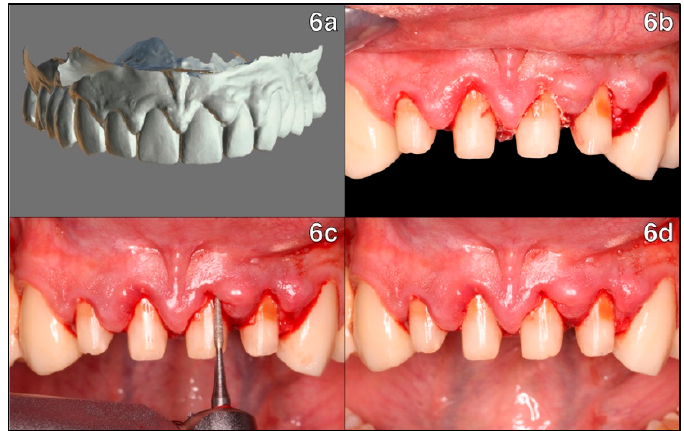
Figure 6. Intraoral scan pre-op and removal of old restorations: ( 6a ) 3D reproduction of the arch after intraoral scanning, performed before old restorations are removed; ( 6b ) after removal of the old restorations, intrasulcular cement can be observed in the sockets of teeth 1.1-2.1-2.2; ( 6c ) trim- ming and removal of excess cement with fine periosteal diamond bur; ( 6d ) frontal view of teeth after preparation.